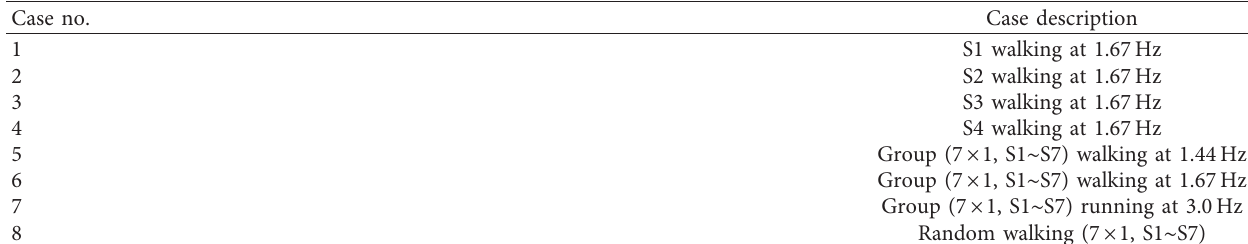
Table 6: Summary of all test cases.